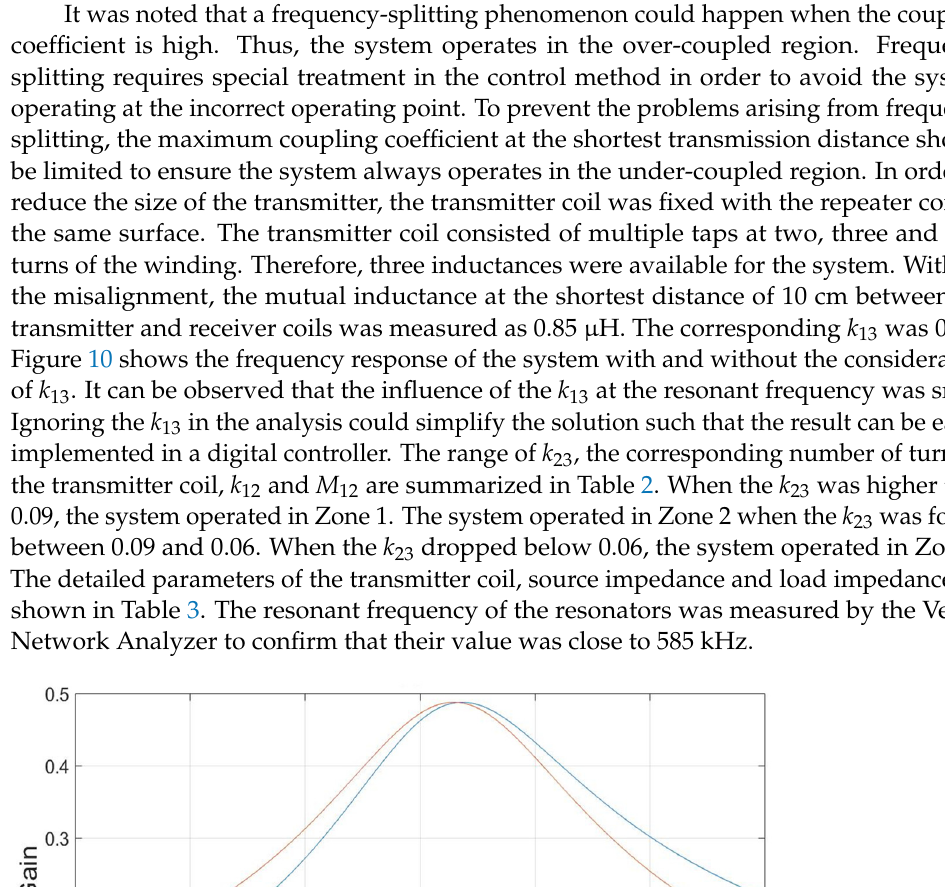
Figure 9. k 23 versus transmission distance and misalignment. Figure 9. 𝑘 (cid:2870)(cid:2871) versus transmission distance and misalignment.